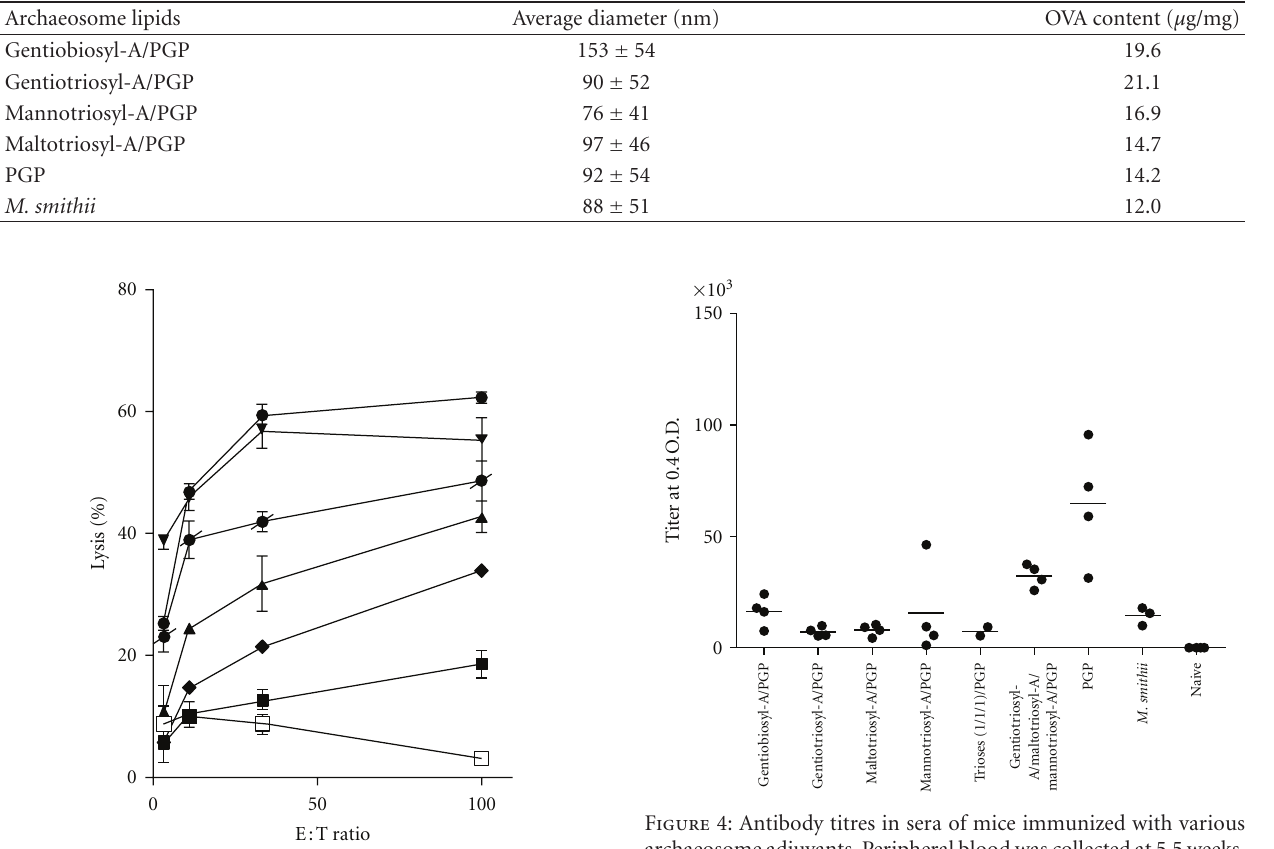
Table 1: Characterization of OVA-archaeosomes.